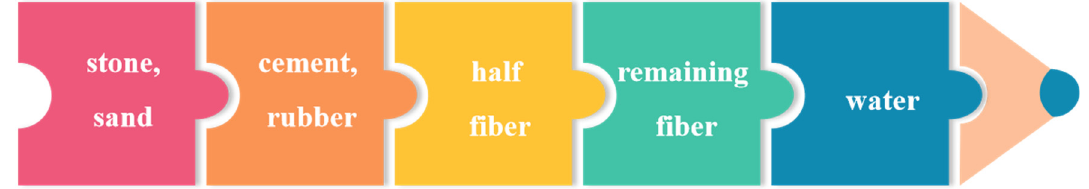
Figure 1. Raw material delivery